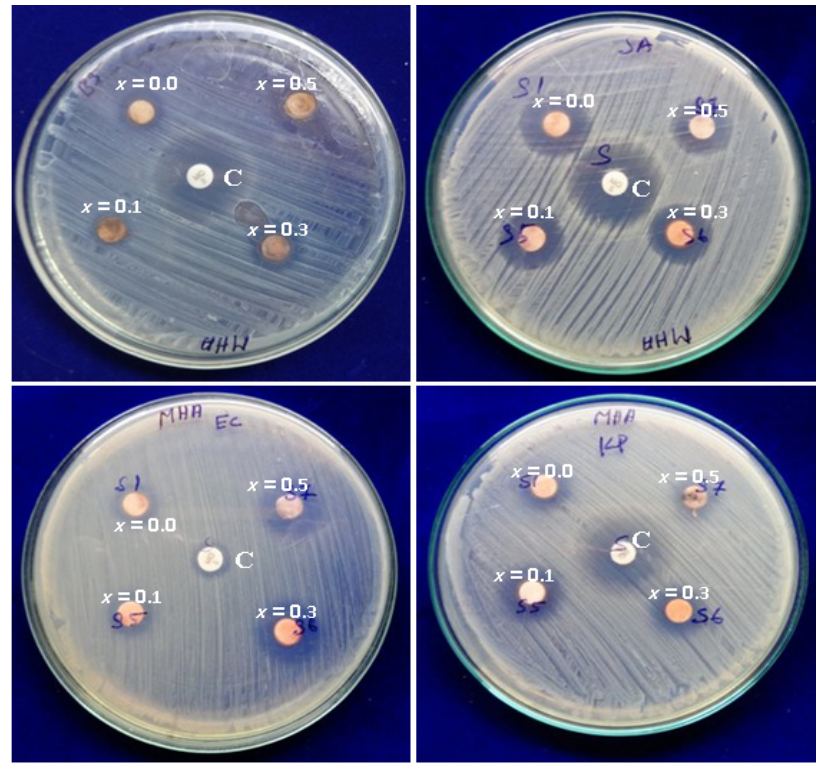
Figure 11. Antibacterial activity of MnCe x Fe 2 − x O 4 (x = 0.0, 0.1, 0.3 and 0.5) NCs. Table 5. Antibacterial activity of spinel MnCe x Fe 2 − x O 4 (x = 0.0, 0.1, 0.3 and 0.5) NCs.